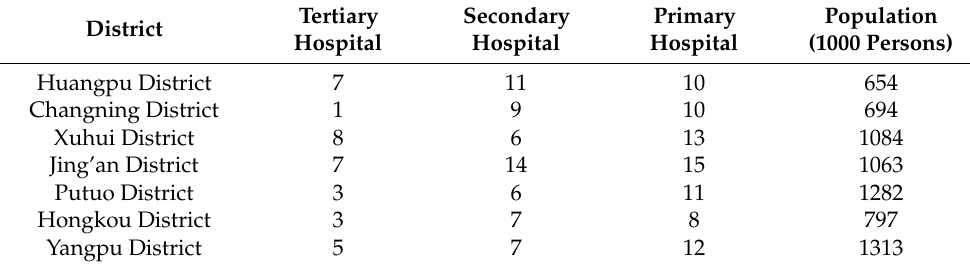
Figure 2. Location of Changning District in Shanghai, China. Table 1. Distribution of three-tier hospitals in the central area of Shanghai.